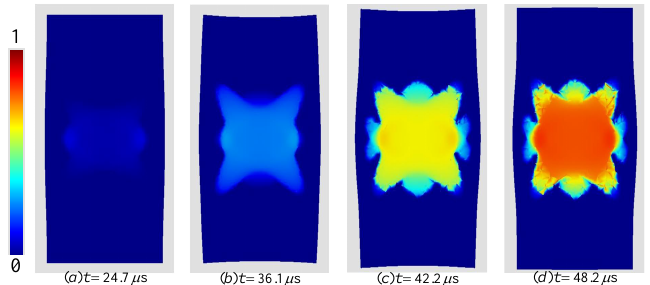
Figure 8. Damage evolution for the medium mesh and low amplitude load at times: ( a ) 24.7 µ s, ( b ) 36.1 µ s, ( c ) 42.2 µ s, and ( d ) 48.2 µ s. The results are shown on the deformed meshes with a magnification factor of